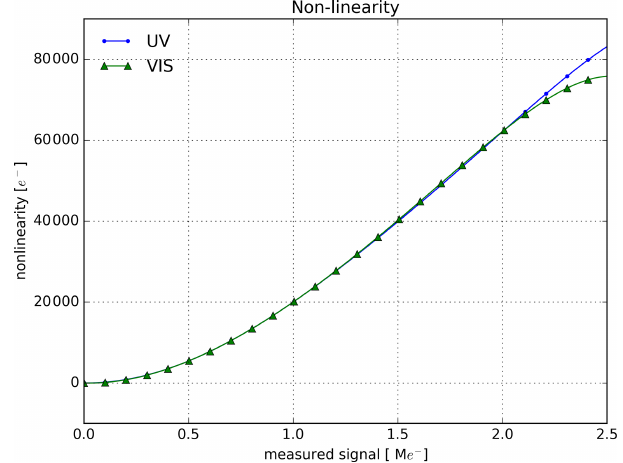
Figure 2. The absolute non-linearity curves for both the UV detec- tor and the VIS detector. The VIS curve is less accurate for higher signals due to the lack of images in these higher signal ranges. At lower values it overlaps with the UV curve. Just as in collection 3, the curve for the UV detector is therefore used for both UV and